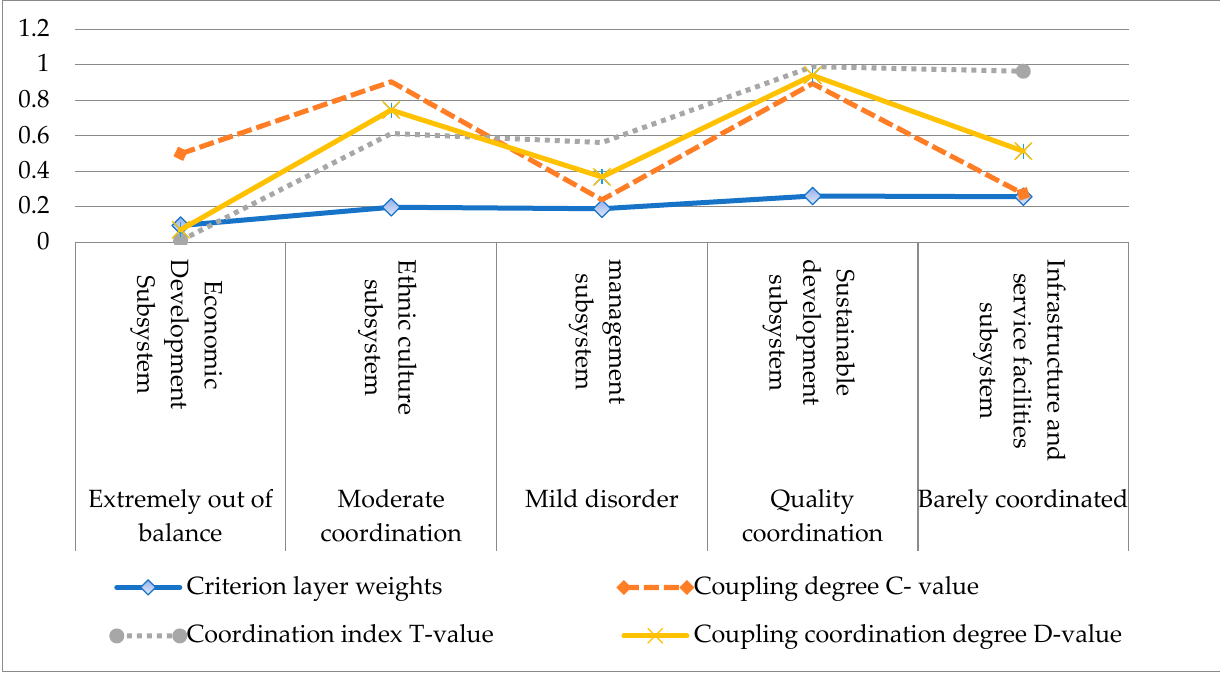
Figure 3. Evaluation of Sustainable Development of Jiaju Tibetan Village.